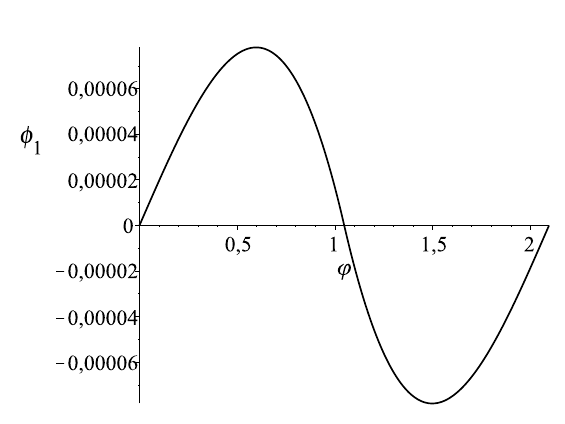
Figure 14: The plot of ϕ 1 = ϕ 1 ( φ )